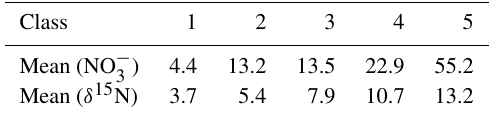
N and δ 15 N means by 3